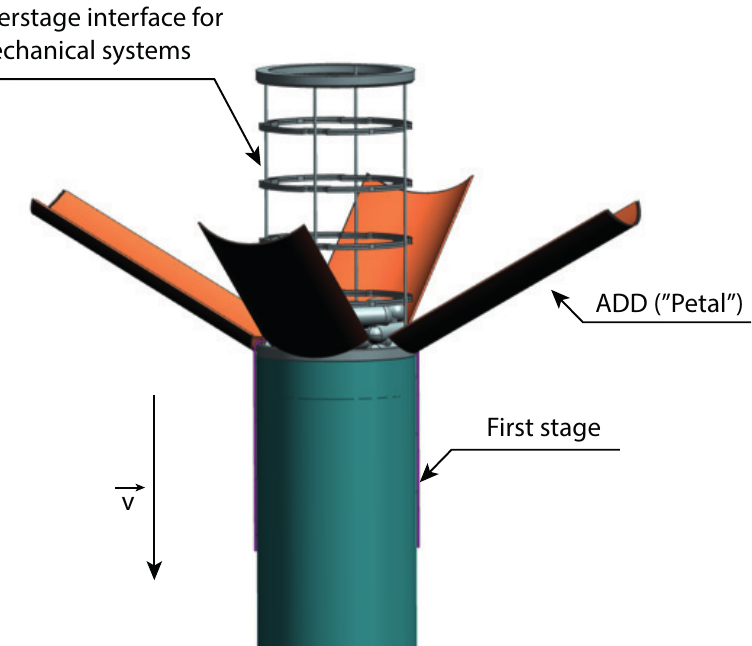
Figure 1. Architectural CAD sketch of the aerodynamic drag devices in open